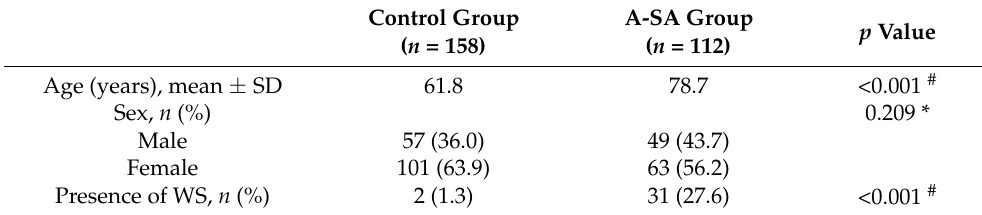
Table 1. Characteristics of the 270 patients in the control and A-SA groups.